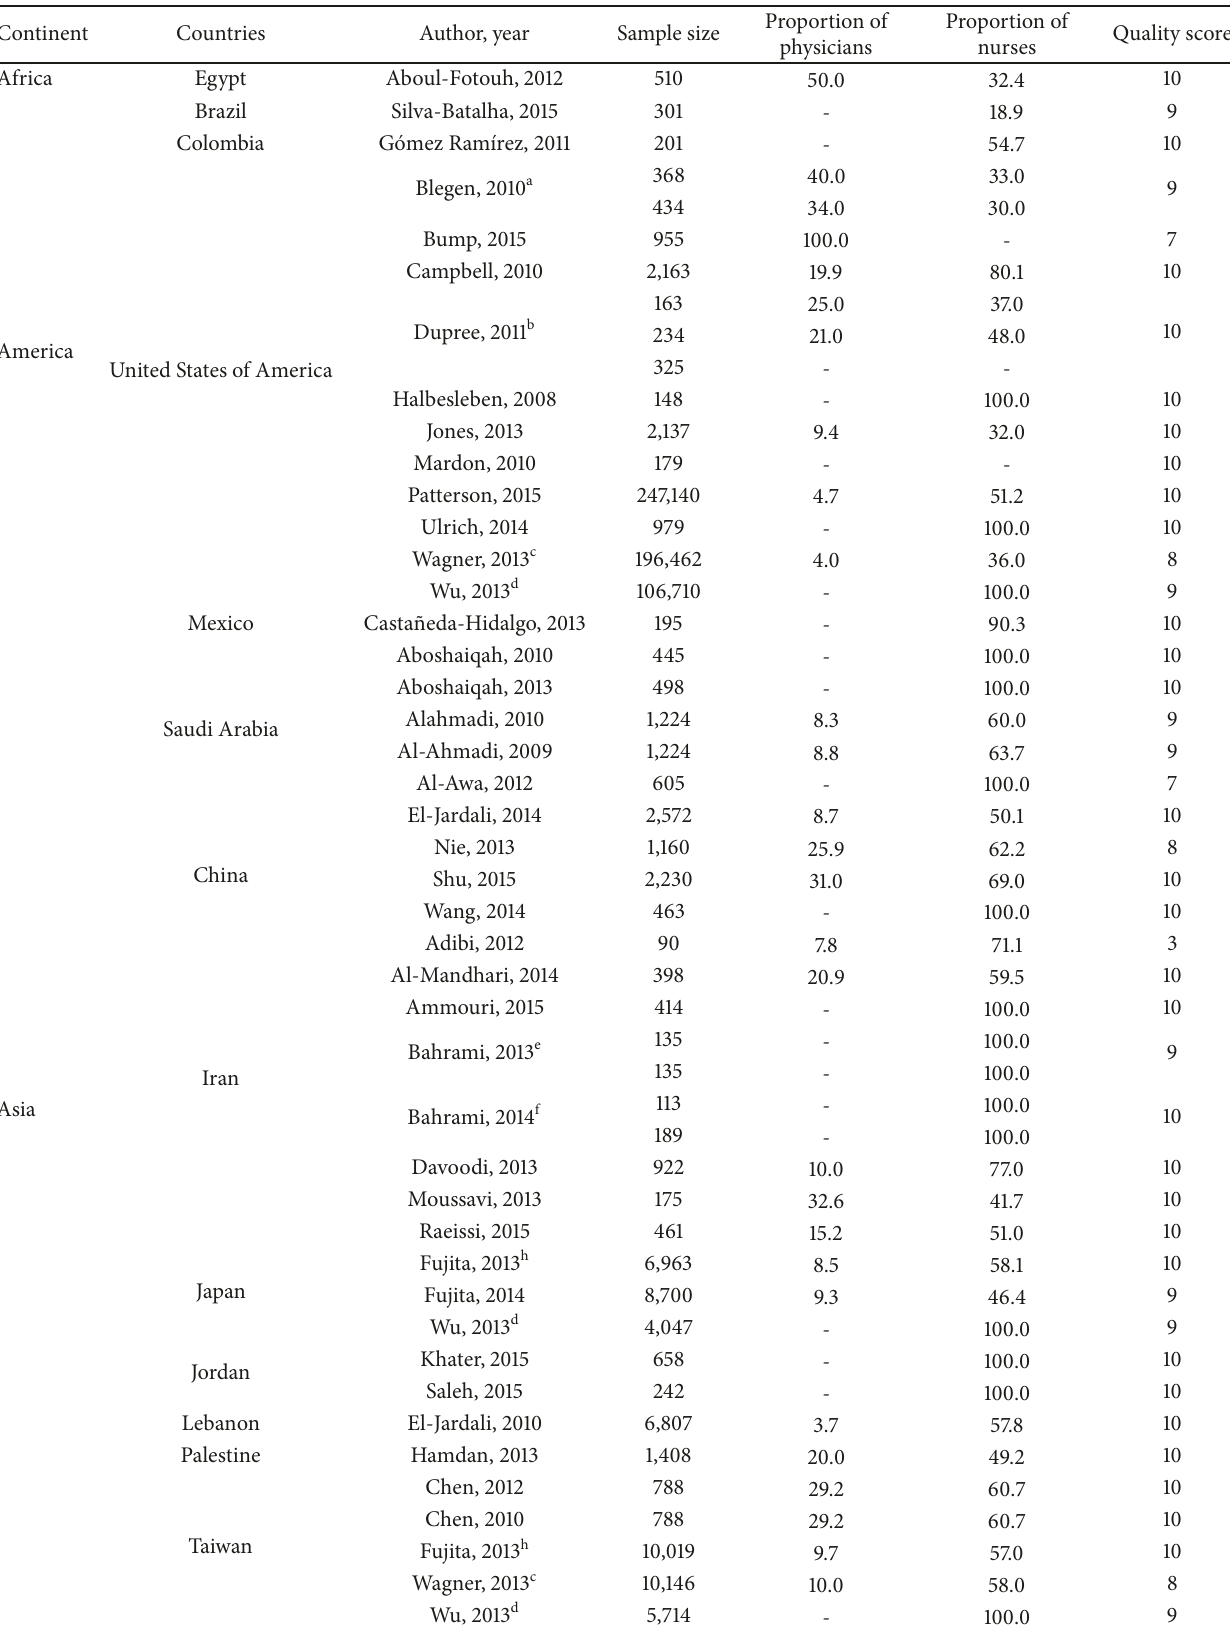
Table 2: Characteristics of included studies